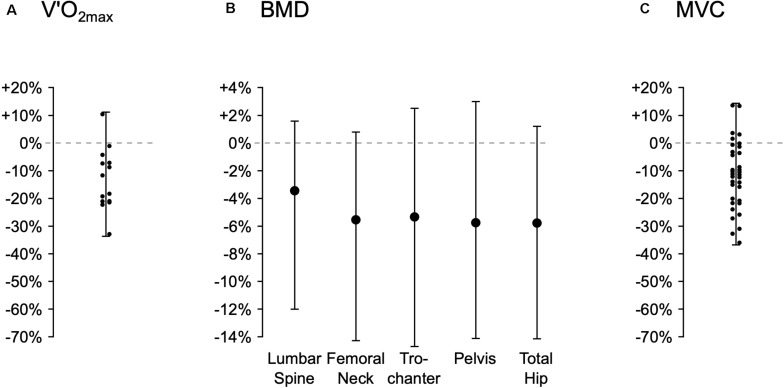
Range of individual changes (percentage change from pre- to post-flight) in key physiological parameters from spaceflight studies. The figure shows derived estimates of changes in maximal rate of oxygen uptake (VO2max, Panel A, extracted from Figure 3; Moore et al., 2014), bone mineral density (BMD, Panel B, extracted from Figure 2; Sibonga et al., 2015) and maximal force production of the knee extensors during a maximal voluntary contraction (MVC, Panel C, extracted from Figure 6; English et al., 2015). Minima, mean, and maxima data, and where possible (i.e., no overlap of data points) individual data points, were extracted from published figures using WebPlotDigitizer (United States). Thus, for Figure 2 of Sibonga et al. (2015), only the minima, mean and maxima data are presented.